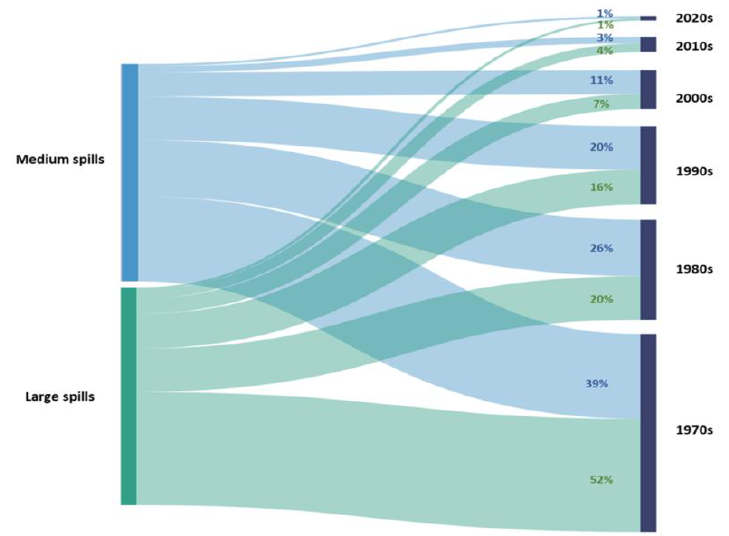
Figure 1 . Tanker spills per decade, 1970 – 2021. Reproduced with permission from ITOPF, 2022 [7].